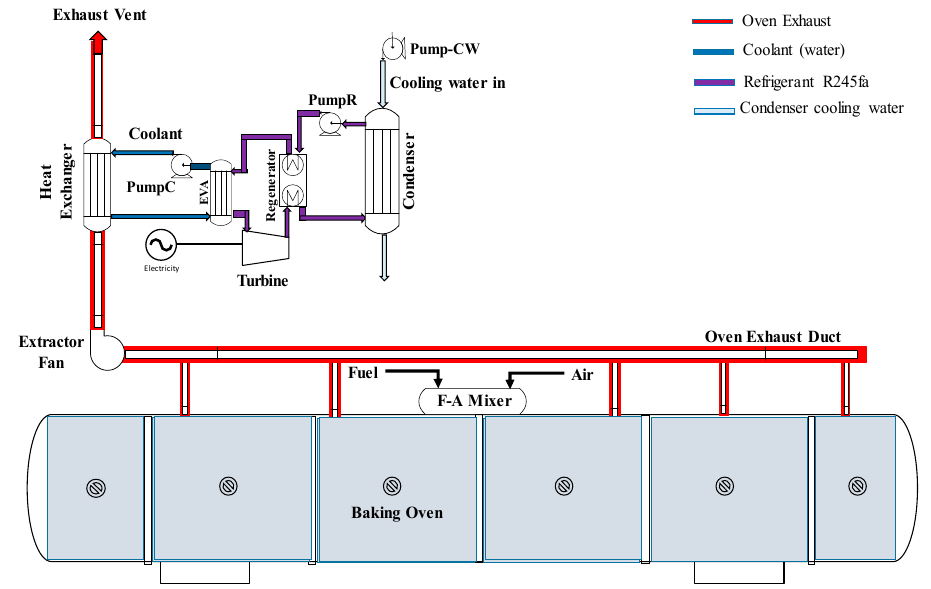
Figure 5. Schematic of a baking oven waste heat recovery system to produce electricity using the Regenerative Organic Rankine Cycle.